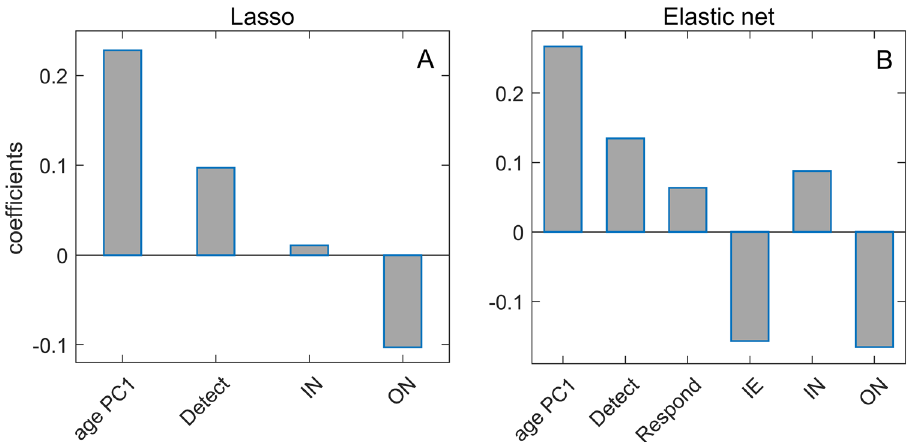
Figure 2. Lasso and Elastic Net regressions with m/r as the response variable. ( A ) Regression coefficients of variables selected by Relaxed Lasso regression, ( B ) Regression coefficients of variables selected by Relaxed Elastic Net regression, age PC1 – age principal component 1, Detect – GHSI Detect category, Respond – GHSI Respond category, IE – net immigration, IN – physical inactivity, ON – the onset of the